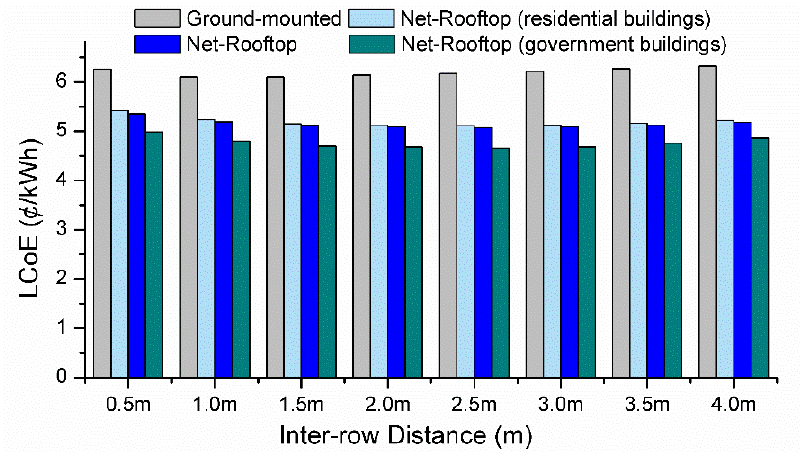
Figure 9. LCoE of ground-mounted and rooftop PV configurations at various interrow